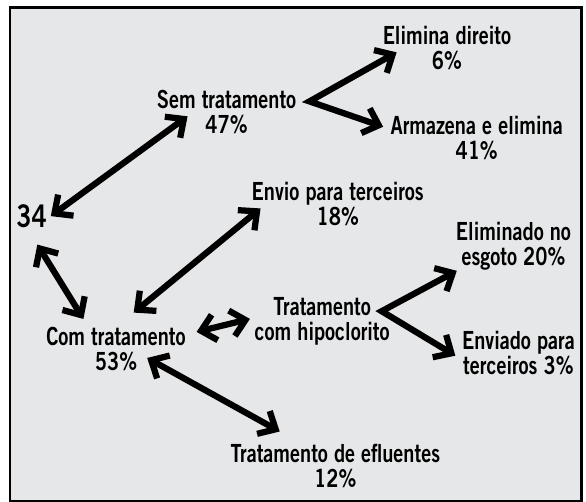
Figura 2 – Representação das formas de eliminação do descarte de equipamentos de hematologia praticadas nos laboratórios em Curitiba